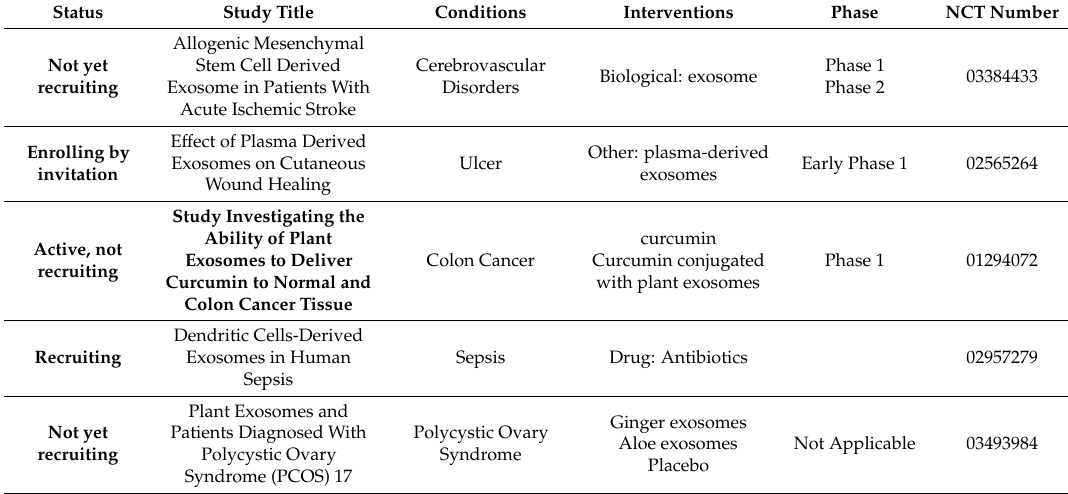
Table 2. List of the clinical studies involving the usage of exosomes as DDSs, or related studies. Study Titles are in bold for the most relevant